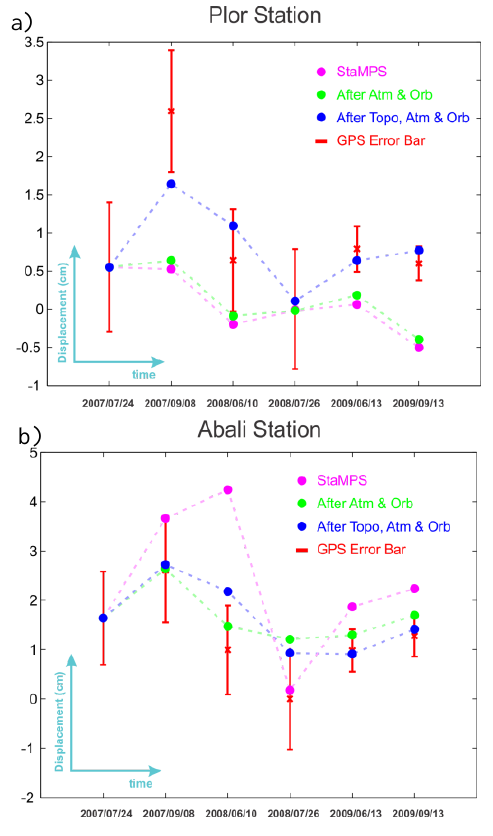
Figure 9: Comparison between GPS measurements and ALOS observation, projected on line of sight for PLOR and ABALI stations, by Stamps method (magenta), after atmospheric